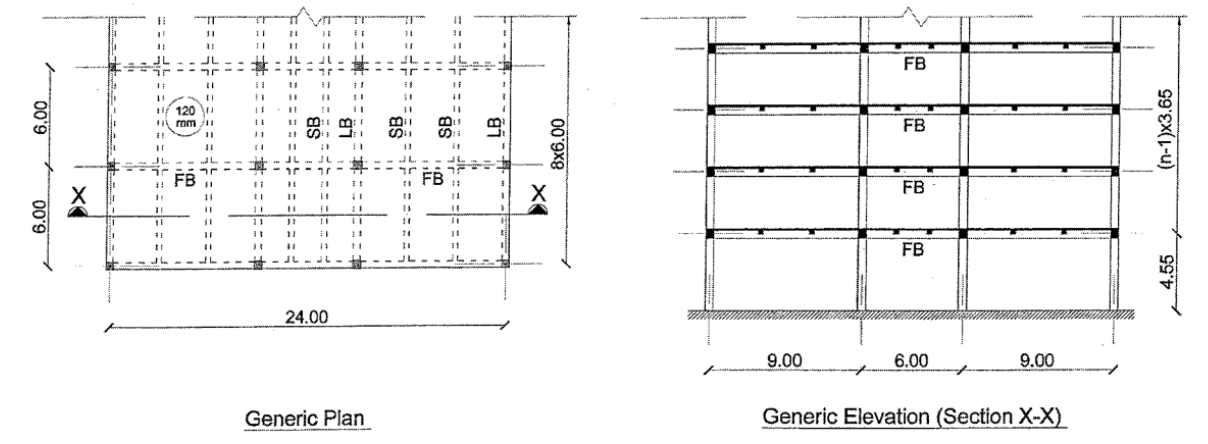
Figure 1. Plan and elevation of the structure [30]. Table 1. Section and reinforcement details for the beams (# is reinforcement bar diameter) [20].